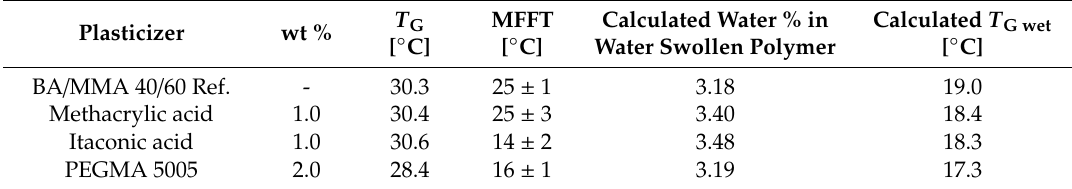
Table 2. Minimum film-formation temperature (MFFT) and T G for temporary hydroplasticizer (THP) latexes, THP amount in the latex in wt % based on the solids content, theoretical water weight % of water saturated polymer calculated with Barrie’s method and theoretical wet T G calculated based on